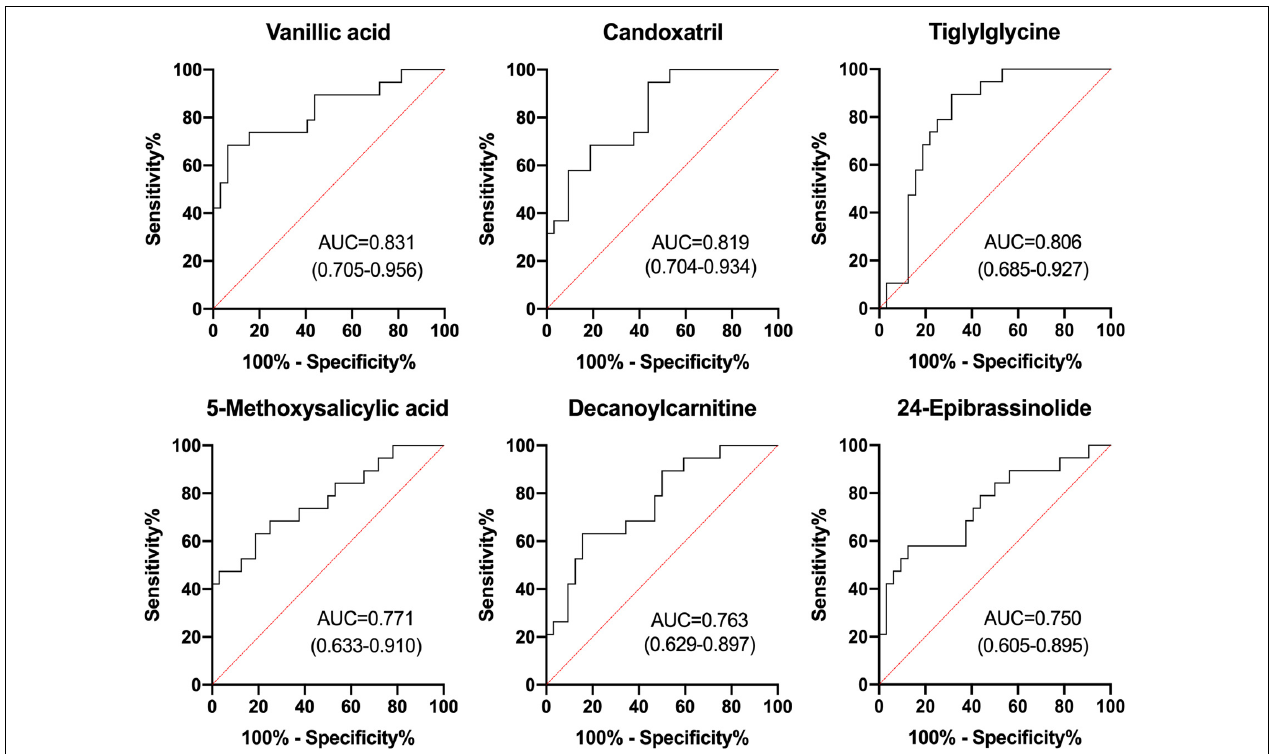
FIGURE 6 | ROC analyses of selected differential metabolites in EA.